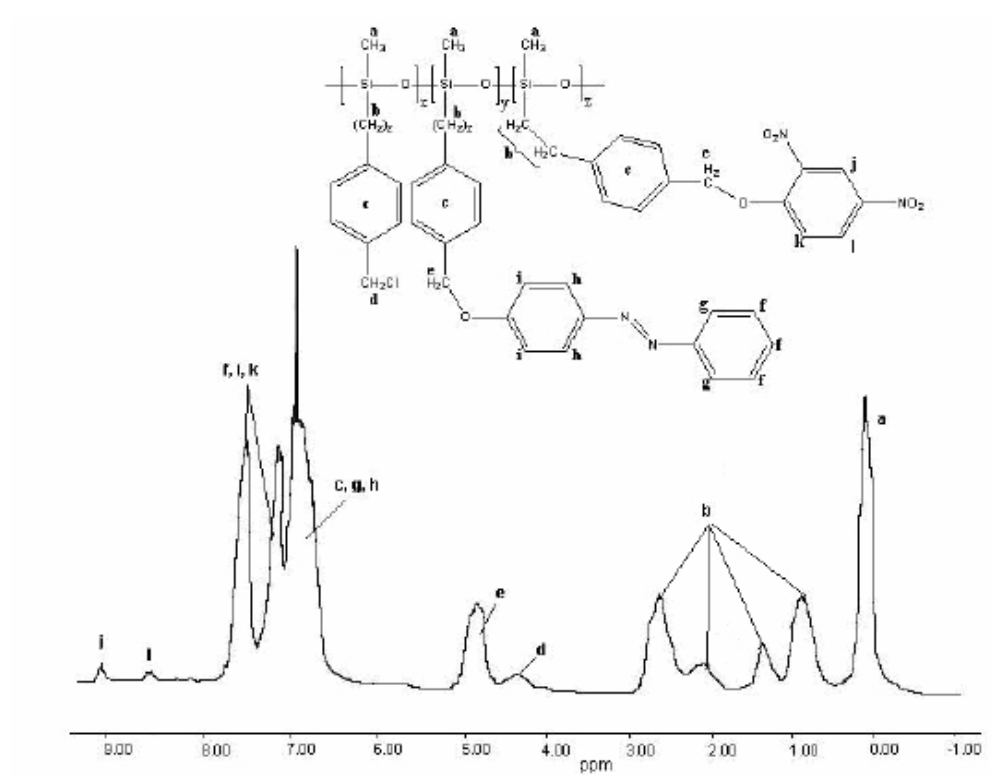
Fig. 4 1 H-NMR spectra corresponding to the Sample 5 (CDCl 3